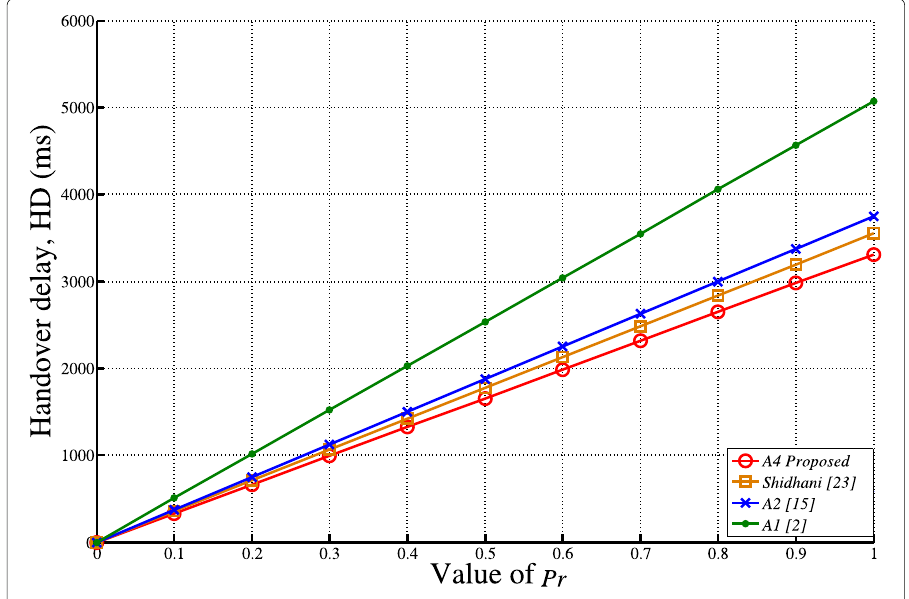
Fig. 18 Handover delay with Pr